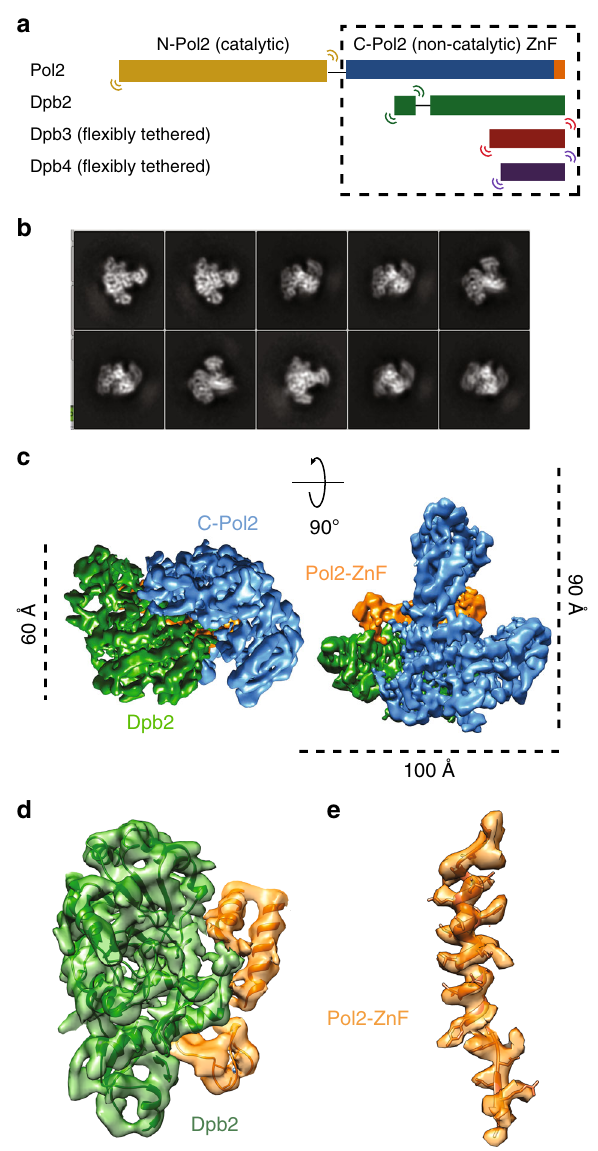
Fig. 1 Cryo-EM structure of the tetrameric Pol epsilon complex, lacking the catalytic domain (deltacat). a Subunit composition and domain organization of yeast Pol epsilon. N-Pol2 stands for N-terminal Pol2. C-Pol2 stands for C- terminal Pol2. ZnF stands for zinc- fi nger appendix. b 2D class averages of deltacat. c Surface rendering of the deltacat structure solved to 4.45 Å resolution. Dpb2 is green, Pol2 catalytically dead polymerase fold is blue, and Pol2 zinc- fi nger appendix is orange. d Atomic model for the yeast Dpb2 (green) bound to the Pol2 C-terminal zinc- fi nger appendix (orange), built into the cryo-EM map. e Detail of the Pol2 zinc- fi nger appendix (further map sharpening with